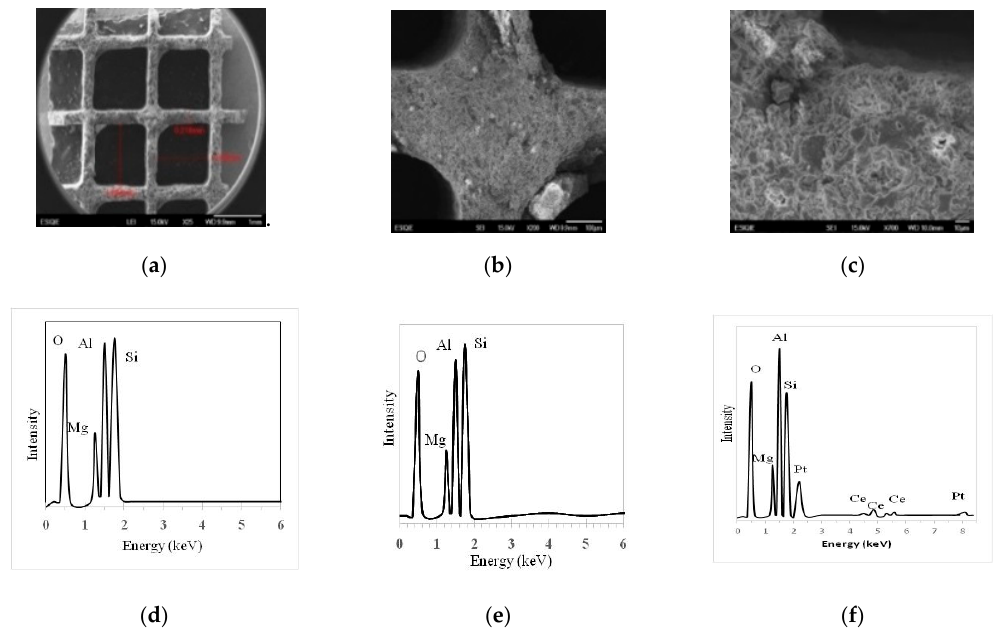
Figure 3. Micrograph of the monolith structure observed with magnification of 25X ( a ), 200X ( b ) and 700X ( c ). The corresponding EDS analysis of the monolith structure is shown in ( d ); the analysis on the alumina layer is in ( e ) and the active metals Ce and Pt in ( f ). Table 2. Chemical analysis of the catalytic converter by EDS for the monolithic structure and the active film. Chemical Element In the Monolith Structure (wt.%) In the Supported Active Phase